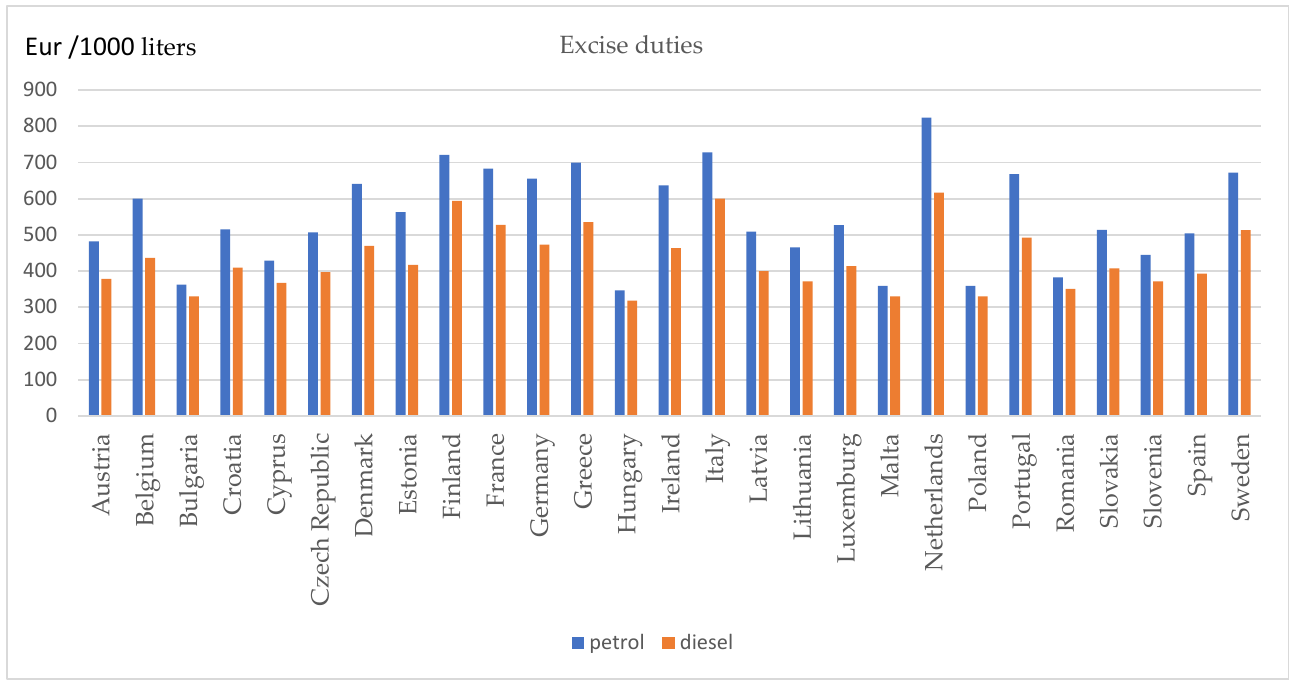
Figure 8. Additional electrical energy obtained from renewable sources until 2028. Source: own elaborations.